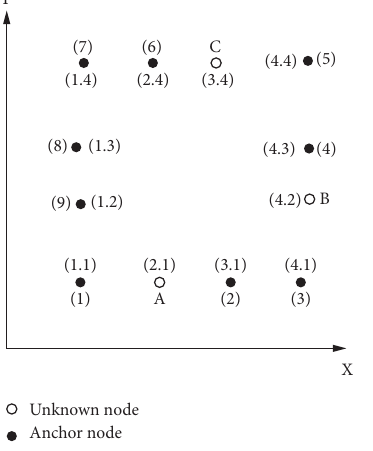
Figure 15: Node distribution of